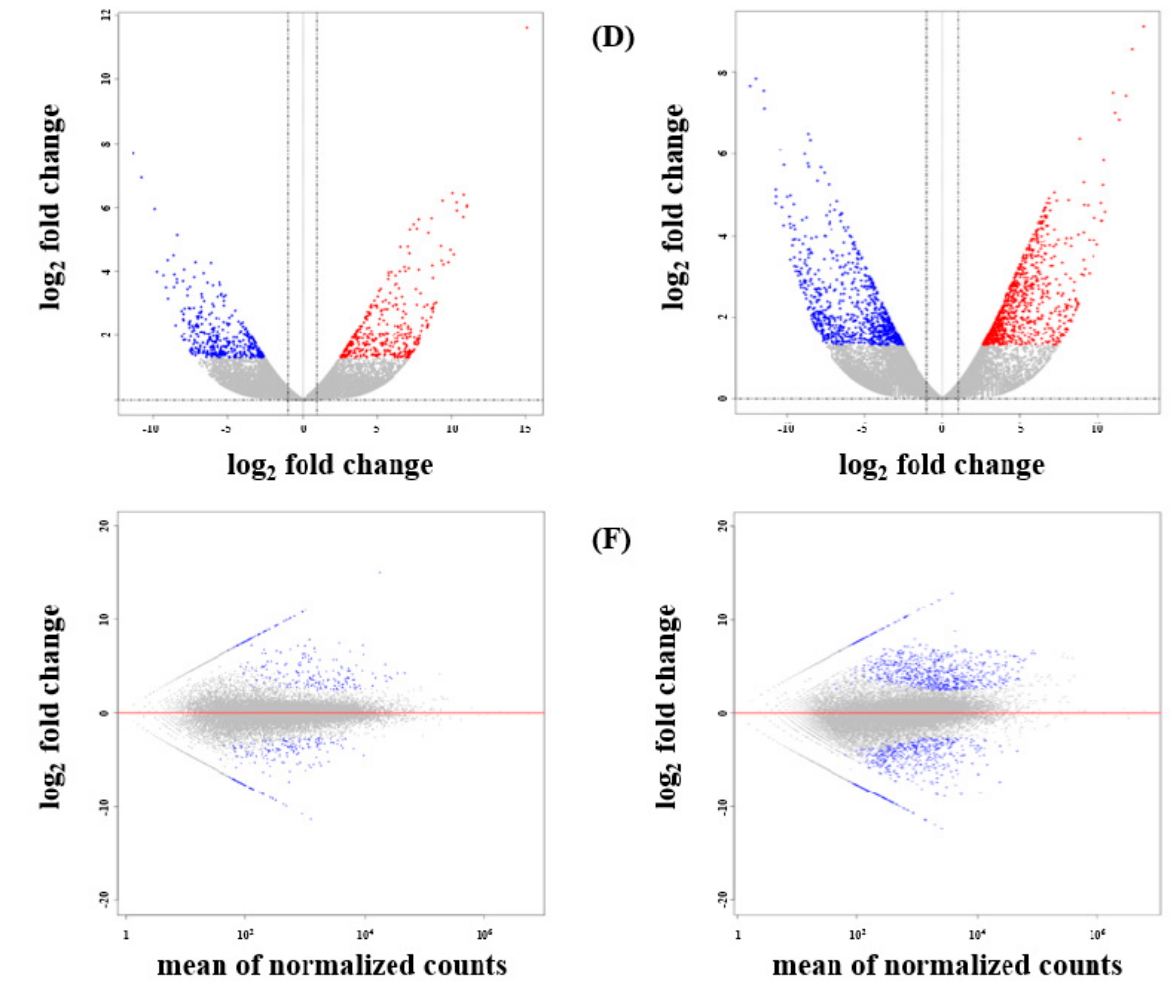
Figure 2. The transcriptional profiles of control vs. ethylene in green ‘Hayward’ and gold ‘Haegeum’ kiwifruit. ( A , B ) Heat map visualization. Each gene is represented by a single row. Red indicates relatively high levels, genes with relatively low levels are shown in blue. ( C , D ) Volcano plot of the identified genes. The DEGs are shown in red and blue, black indicates genes that were not differentially expressed. ( E , F ) MA plot of the identified genes. The DEGs are shown in gray ( p > 0.05) and blue ( p < 0.05).